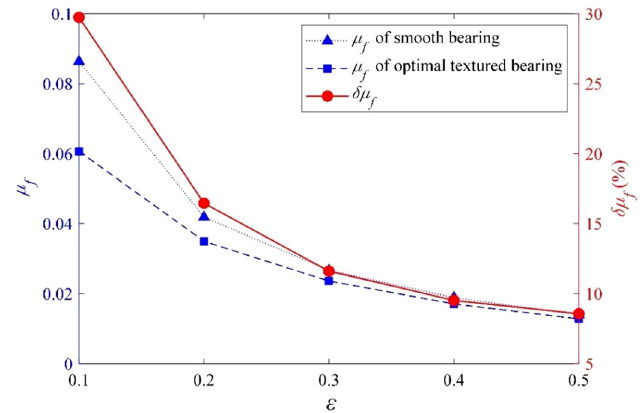
Fig. 11. m f and dm f under e =0.1 – 0.5, ’ = 0, N =2000 rpm.